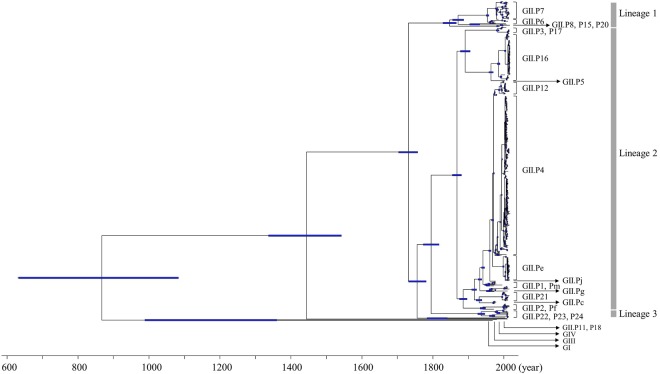
Time-scaled phylogenetic tree of the full-length norovirus RdRp regions constructed by the Bayesian MCMC method. The maximum clade credibility tree with a dataset including norovirus GI.P1, GII, GIII, and GIV is shown. The blue bars indicate the 95% HPD for the estimated years of common ancestors.